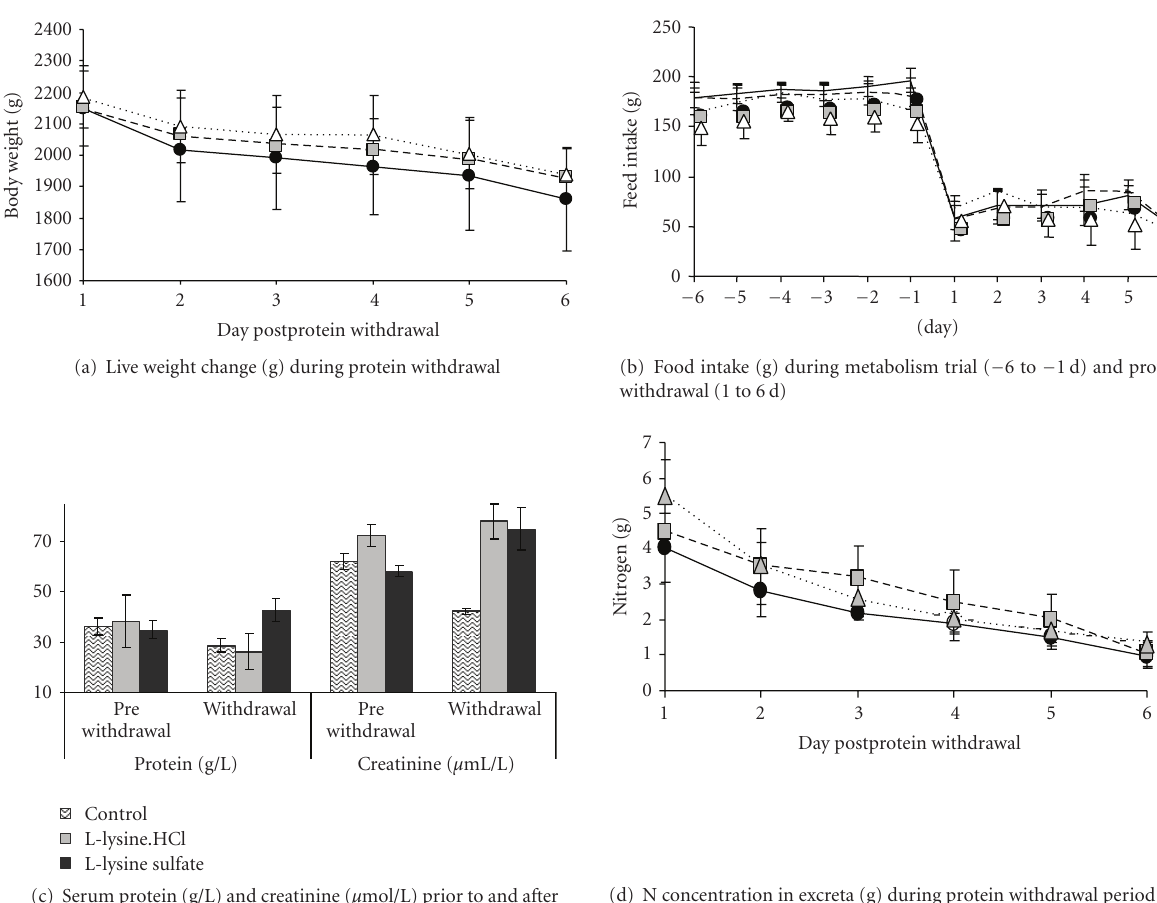
Figure 1: Live weight change, food intake, serum concentrations of total protein and creatinine, and excreta N in experimental broilers. Based on data obtained during the fasting trial conducted at tandem with the metabolism trial ( n = 10) selected at random from each treatment group. In the line diagrams solid, dashed, and dotted lines, respectively, indicate the control, L-lysine.HCl, and L-lysine sulfate dietary